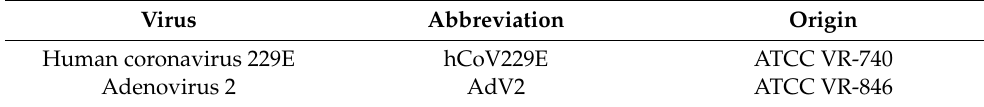
Table 4. Origin information of experimental